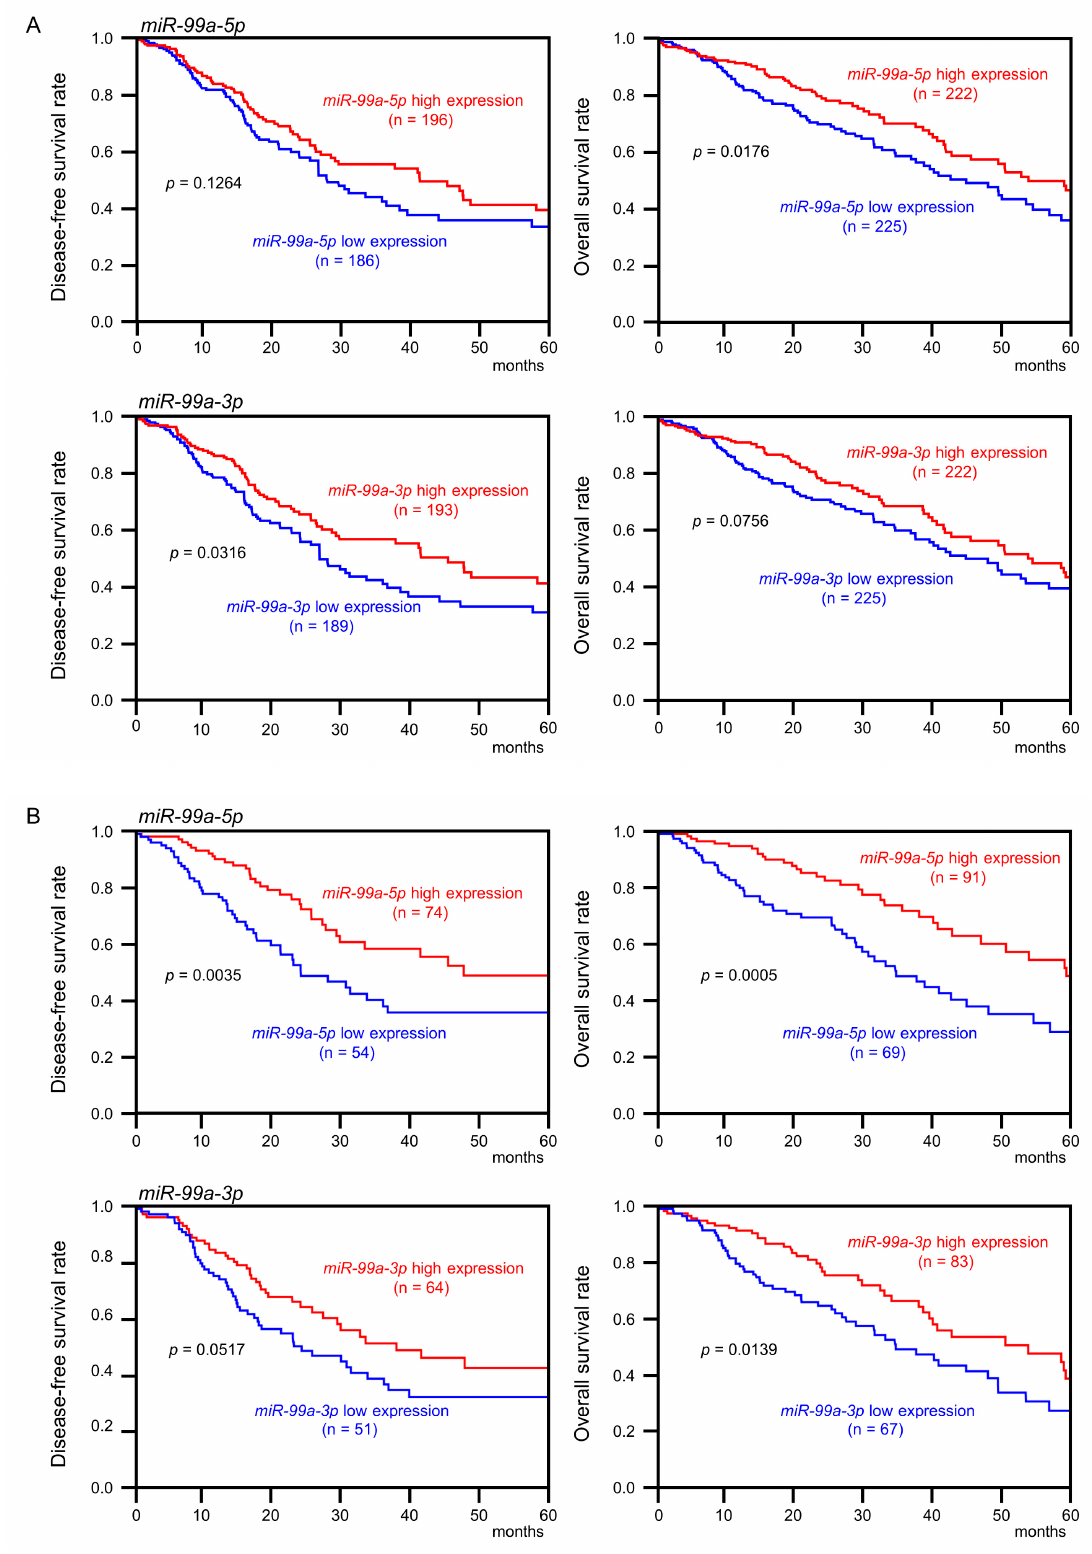
Figure 2. Clinical significance of miR-99a-5p and miR-99a-3p expression in LUAD. ( A ) The patients were divided into two groups according to the median expression level of miR-99a-5p or miR-99a-3p : high (red lines) and low (blue lines) expression groups. ( B ) The patients were divided into two groups, top 25% and low 25%. High expression of miR-99a-5p and miR-99a-3p is represented by red lines; low expression of these miRNAs is represented by blue lines.